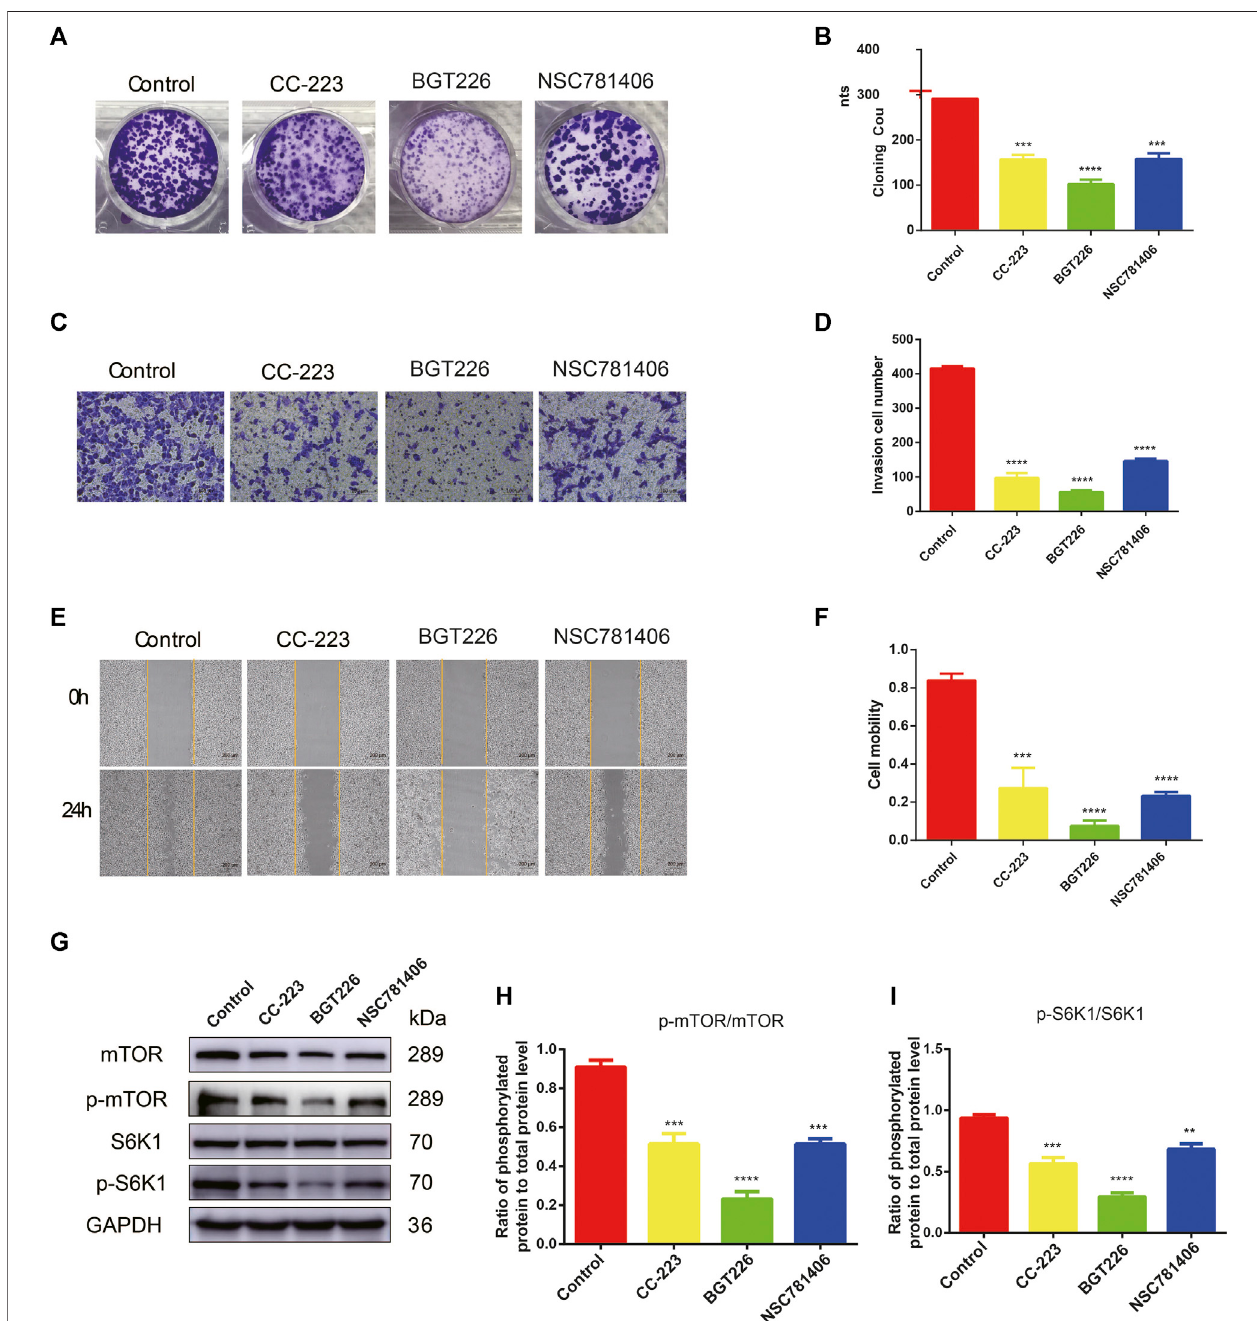
FIGURE 3 | CC-223, NSC781406, and BGT226 inhibit the proliferation, invasion and migration of PANC-1 cells via mTOR/S6K1 signaling. (A) Colony formation assay. Cells were treated with 20 μ M CC-223, NSC781406, and BGT226 and incubated for 14 days. (B) Statistical bar chart of the number of clones. (C) Transwell invasive assay. Cells were treated with 20 μ M CC-223, NSC781406, and BGT226 and incubated for 24 h. (D) Statistical bar chart of the number of invasive cells. (E) Wound healing assay. Cells were treated with 20 μ M CC-223, NSC781406, and BGT226 and incubated for 24 h. (F) Statistical bar chart of cell mobility. (G) Westernblot analysisof proteins involved in mTOR/S6K1 signaling in PANC-1 cells. (H) Statistical bar chart ofp-mTOR/mTOR. (I) Statistical bar chart ofp-S6K1/S6K1. ** p < 0.01; *** p < 0.001; **** p < 0.0001.